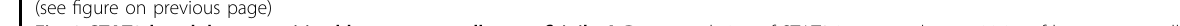
Fig. 2 STAT3 knockdown sensitized lung cancer cells to ge fi tinib. A Downregulation of STAT3 increases the sensitivity of lung cancer cells to ge fi tinib. Cell viability was determined using the MTT assay. B A549/GR and PC-9/GR cells were seeded in six-well plates, incubated overnight, and treated with ge fi tinib (16 μ mol/L) or transfected with STAT3 siRNA plus ge fi tinib (16 μ mol/L) for 7 days. Effect of STAT3 siRNA and ge fi tinib on cell proliferation determined by colony formation assay. C Quanti fi cation of colony formation. D Flow cytometry analysis of apoptotic death of A549/GR and PC-9/GR cells. Cells were treated with either drug alone (16 μ mol/L ge fi tinib) or in combination with STAT3 siRNA for 24 h, and stained with Annexin V/PI. E Quanti fi cation of PI and Annexin V staining. F Effect of ge fi tinib (16 μ mol/L) or ge fi tinib (16 μ mol/L) plus STAT3 siRNA on A549/GR and PC-9/GR cell invasion was determined by transwell assay. G Quanti fi cation of transwell. The Data were mean ± SD, n = 3. **p value <0.01, signi fi cantly